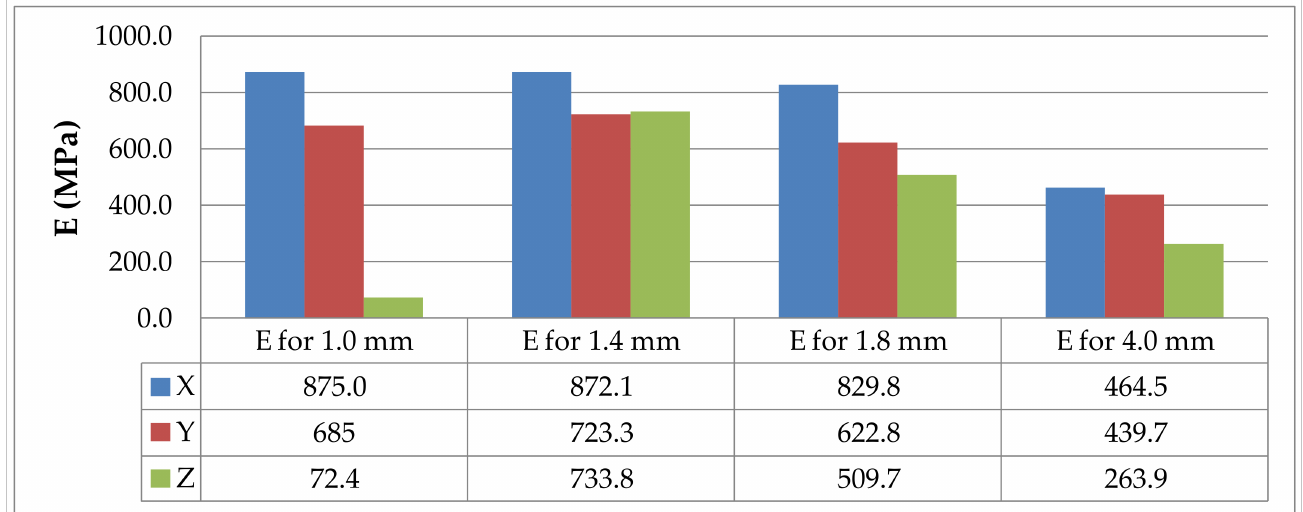
Figure 25. Elasticity modulus E for the PLA specimens differing in thickness and print direction, where X, Y and Z are printing directions.